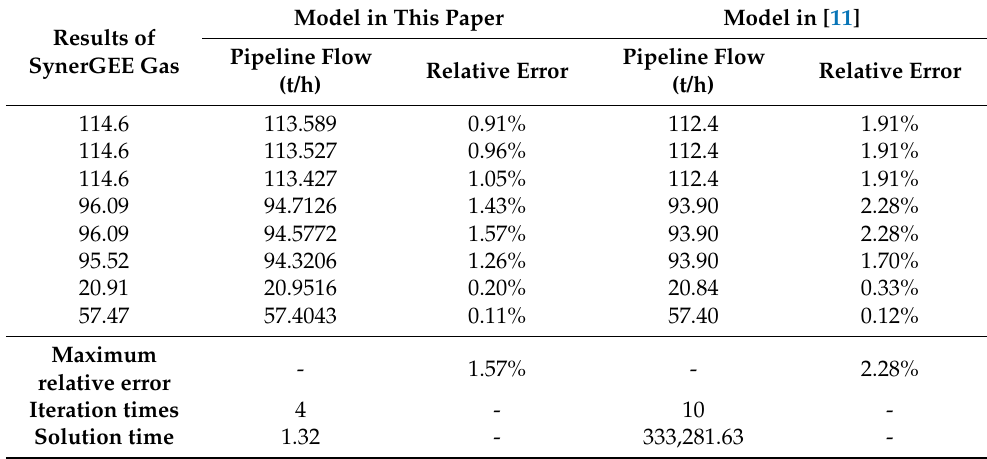
Table 4. Comparison of the solution results of the steam heating network model.